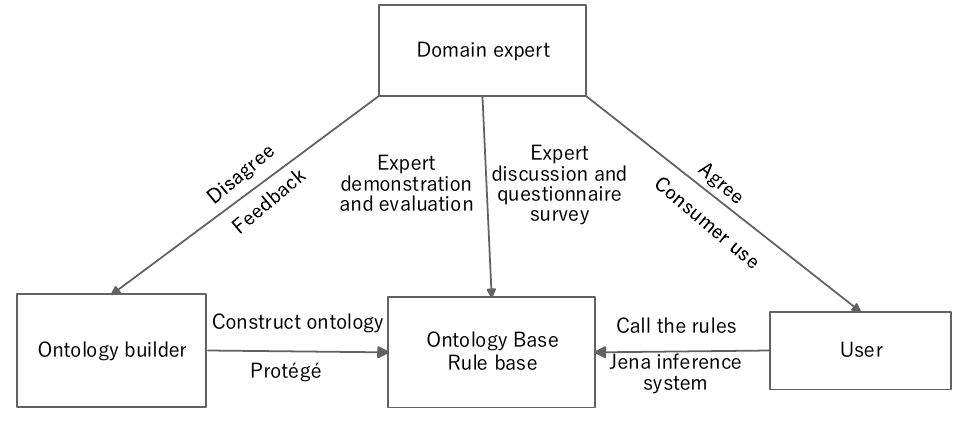
Figure 3. Validation of ontology.